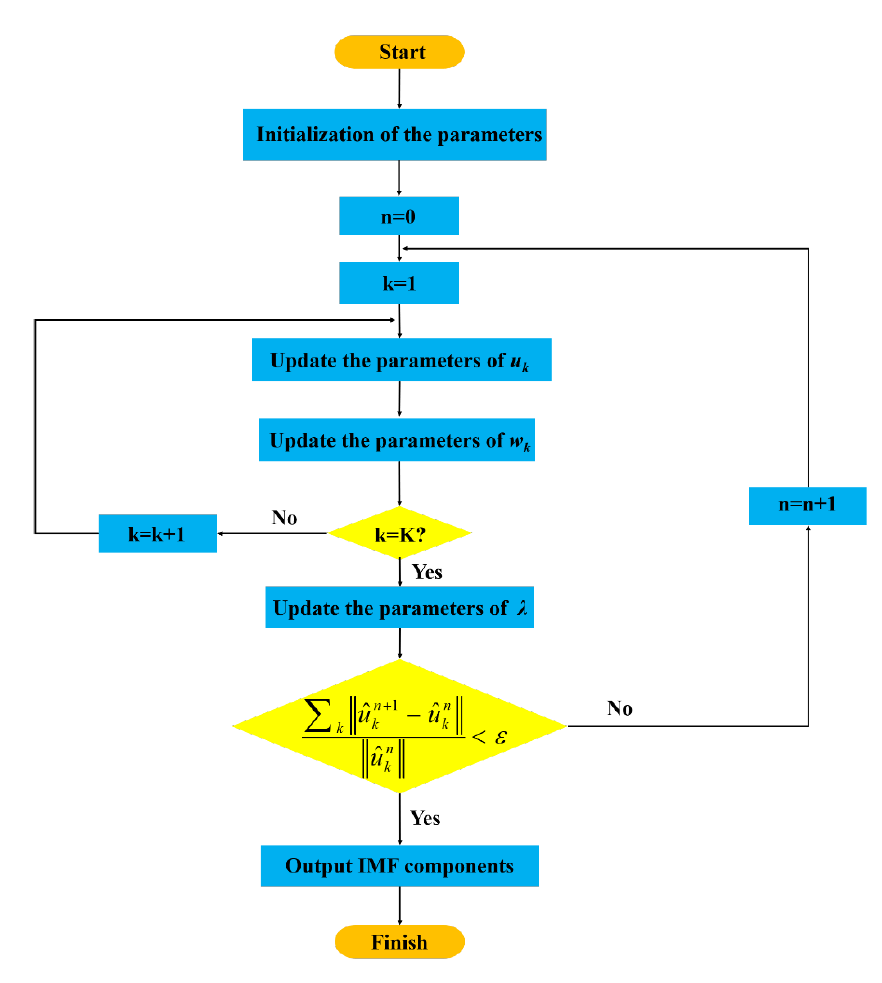
Figure 5. VMD algorithm flow chart.